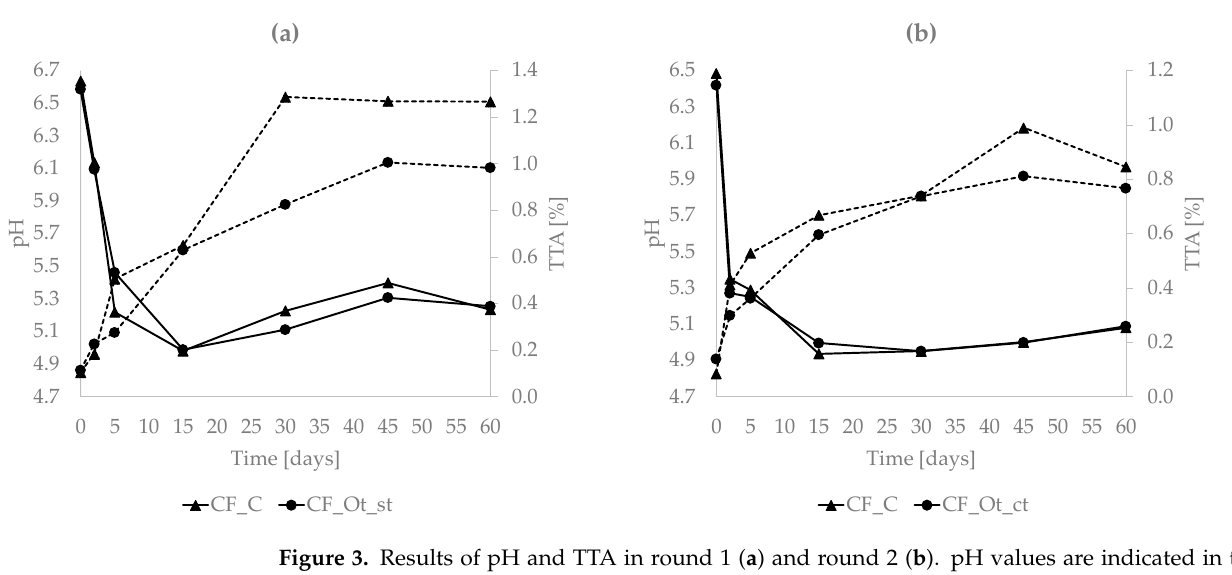
Figure 3. Results of pH and TTA in round 1 ( a ) and round 2 ( b ). pH values are indicated in the primary axis and the results represented with a continuous line; in the secondary axis, TTA values are indicated, and results represented with a dashed line. Table 1. Viable counts of thistle coagulants. Cc: commercial milk coagulant; CE_st: extract from spontaneous O. tauricum flowers; CE_ct: extract from cultivated O. tauricum flowers. Microbial